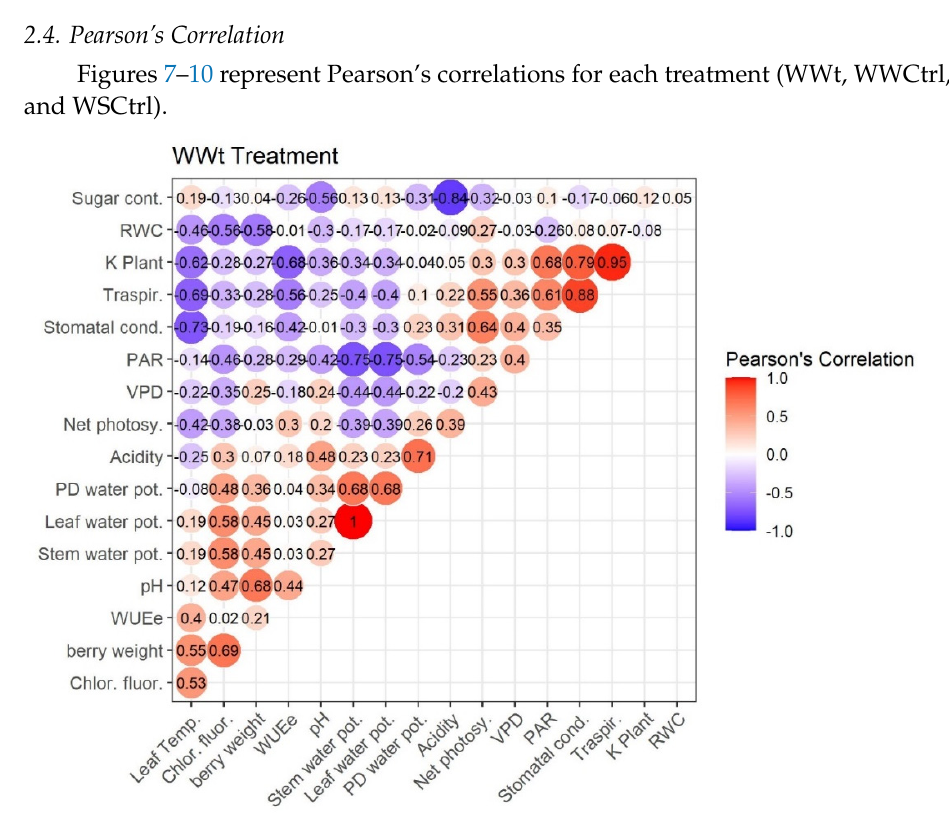
Figure 8. Pearson’s Correlation. WWCtrl Treatment (Well-watered). Ecophysiological and techno- logical correlations between the pairs of traits were analyzed. Correlations were calculated from the mean values of each of the four treatments characterized. Positive correlations are displayed in red